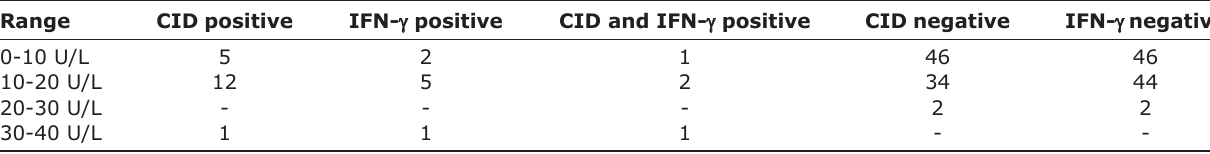
Table-2: ADA levels in cattle and buffaloes tested for bTB by CITT and IFN- γ assay. Range CID positive IFN- γ